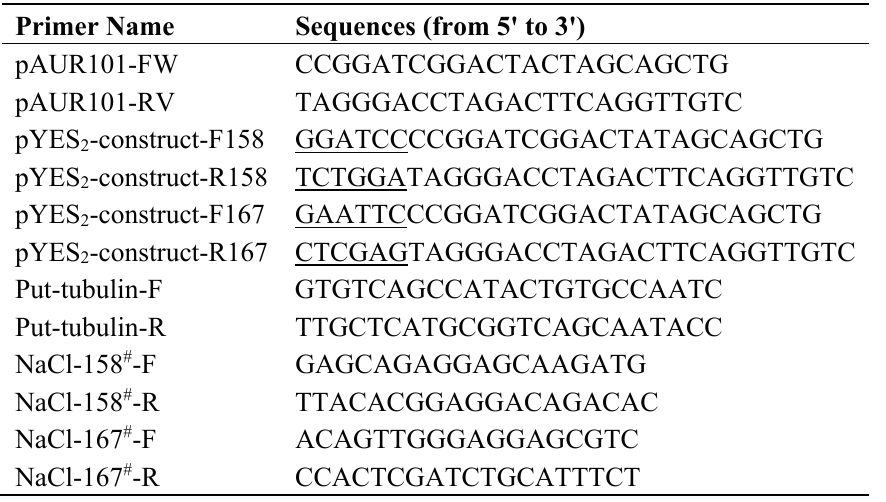
Table 1. Details of the primers used for polymerase chain reaction